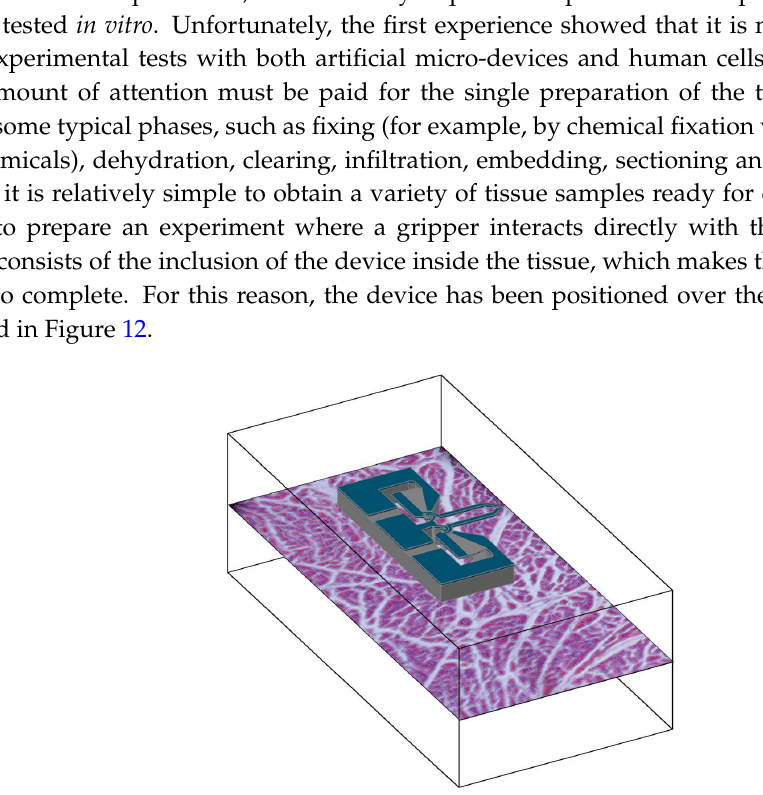
Figure 12. Artificial reconstruction of the superposition of the tissue package and the microgripper